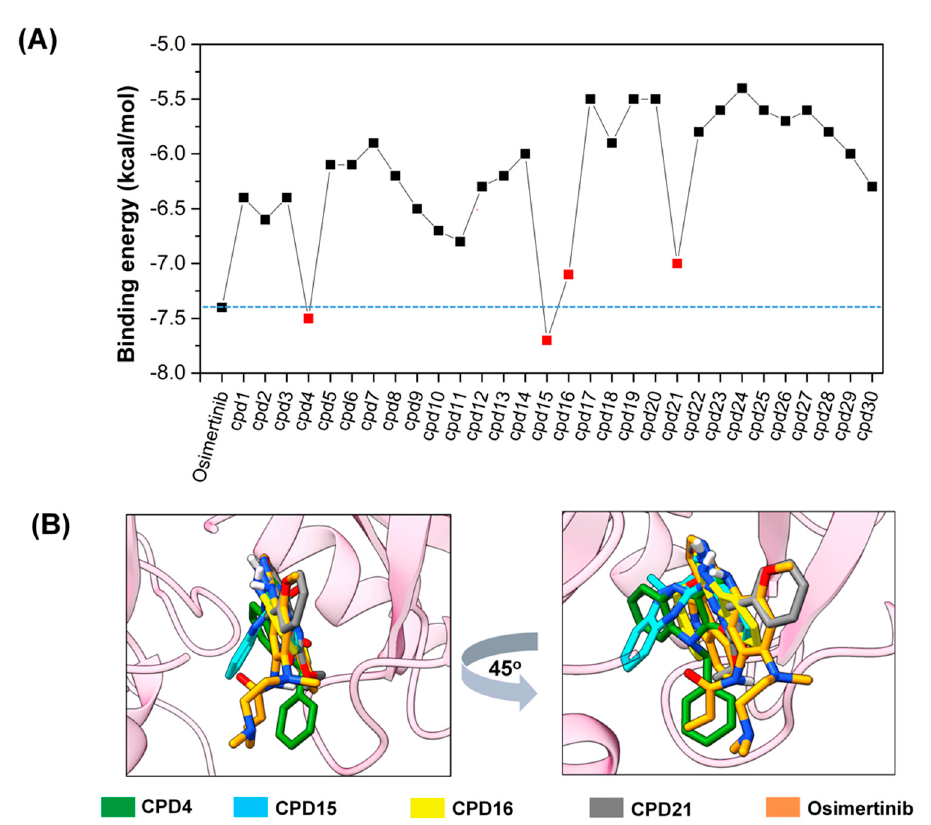
Figure 2. Docking-based virtual screening of 30 quinoxalinone-containing compounds in compari- son to the known drug, osimertinib. ( A ) The four compounds possessing a lower or equal to − 7.0 kcal/mol were then selected to perform experiments as highlighted in red. ( B ) Superimposition of the docked pose of all screened compounds and osimertinib.